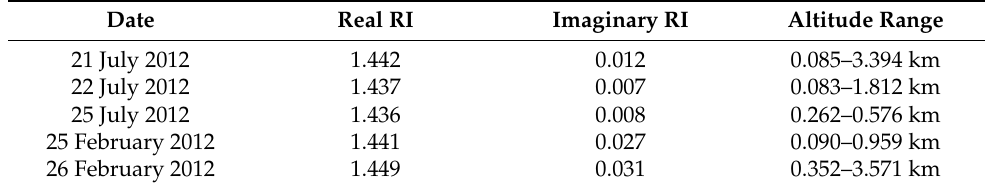
Table 1. Mean values of the real (second column) and imaginary (third column) parts of the ambient complex RI obtained from integrated airborne data for five selected days (first column) during the TCAP. The altitude range above sea level of the corresponding FLs (fourth column) is also